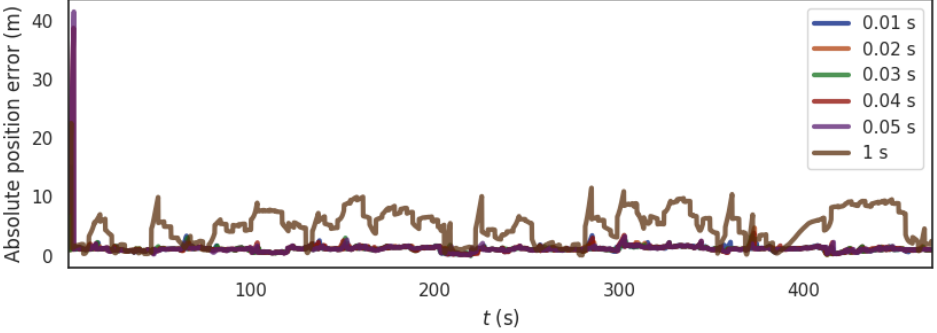
Figure 6. The trend of APE under different time verification thresholds. Table 2. Error parameters of the different time verification thresholds. δ